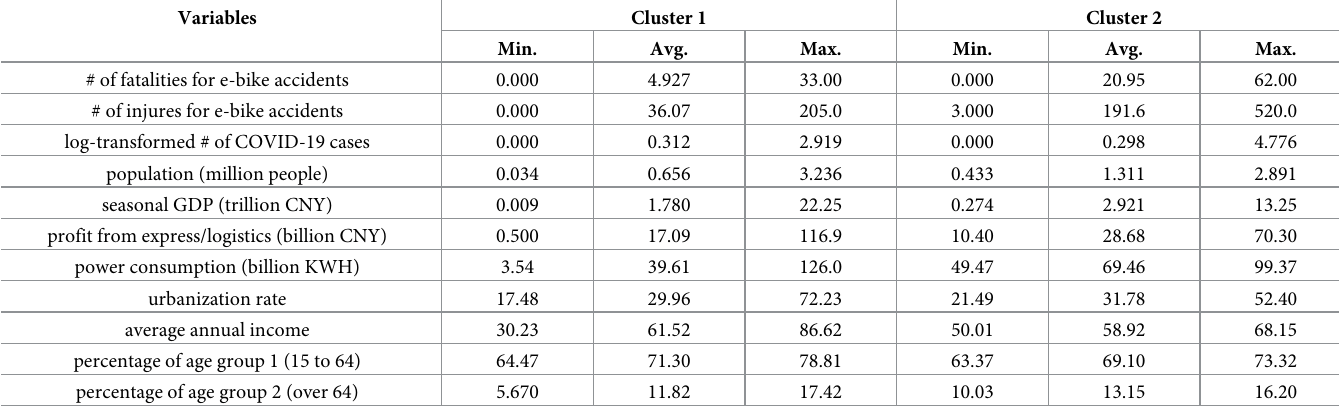
Table 3. Statistics of two clusters of China